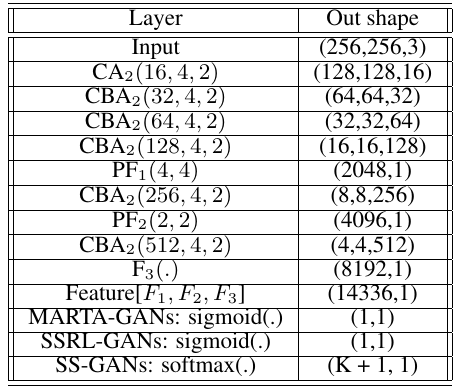
Table 3. Architecture of the Discriminator for the three